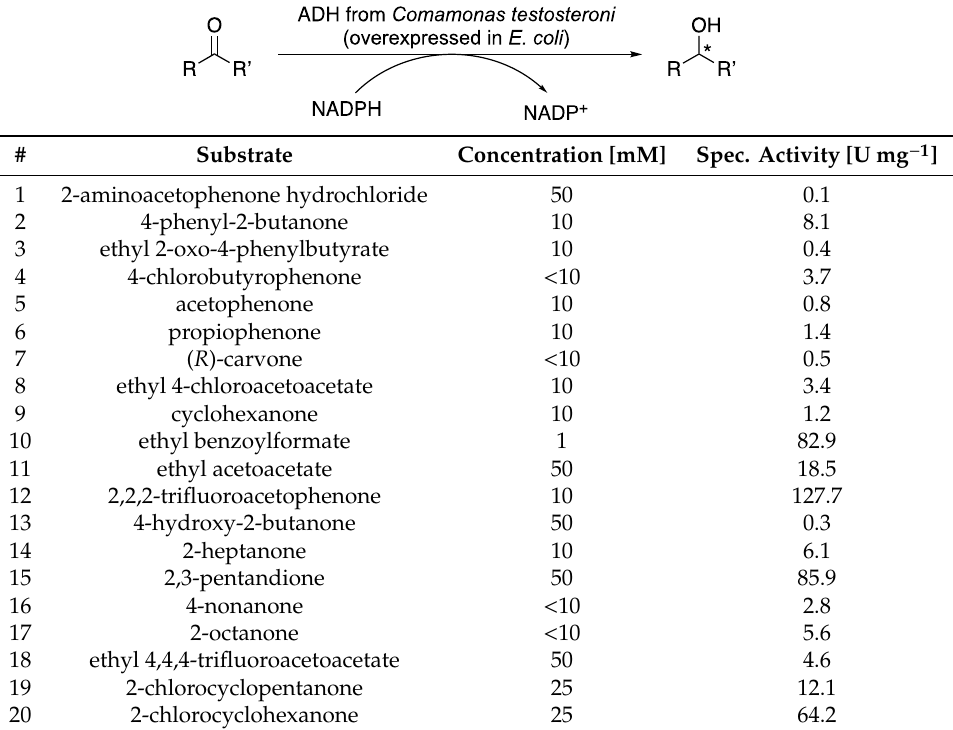
Table 1. Spectrophotometrically determined activities for the reduction of various ketone substrates by CtADH. The activities were obtained by use of the standard spectrophotometric assay. (* marks the chiral center of the product.)